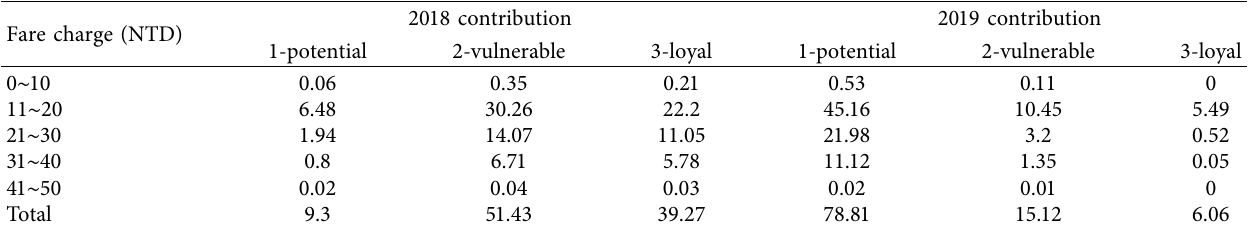
Table 18: % annual MRT revenue generated among different customer groups in 2018 and 2019.